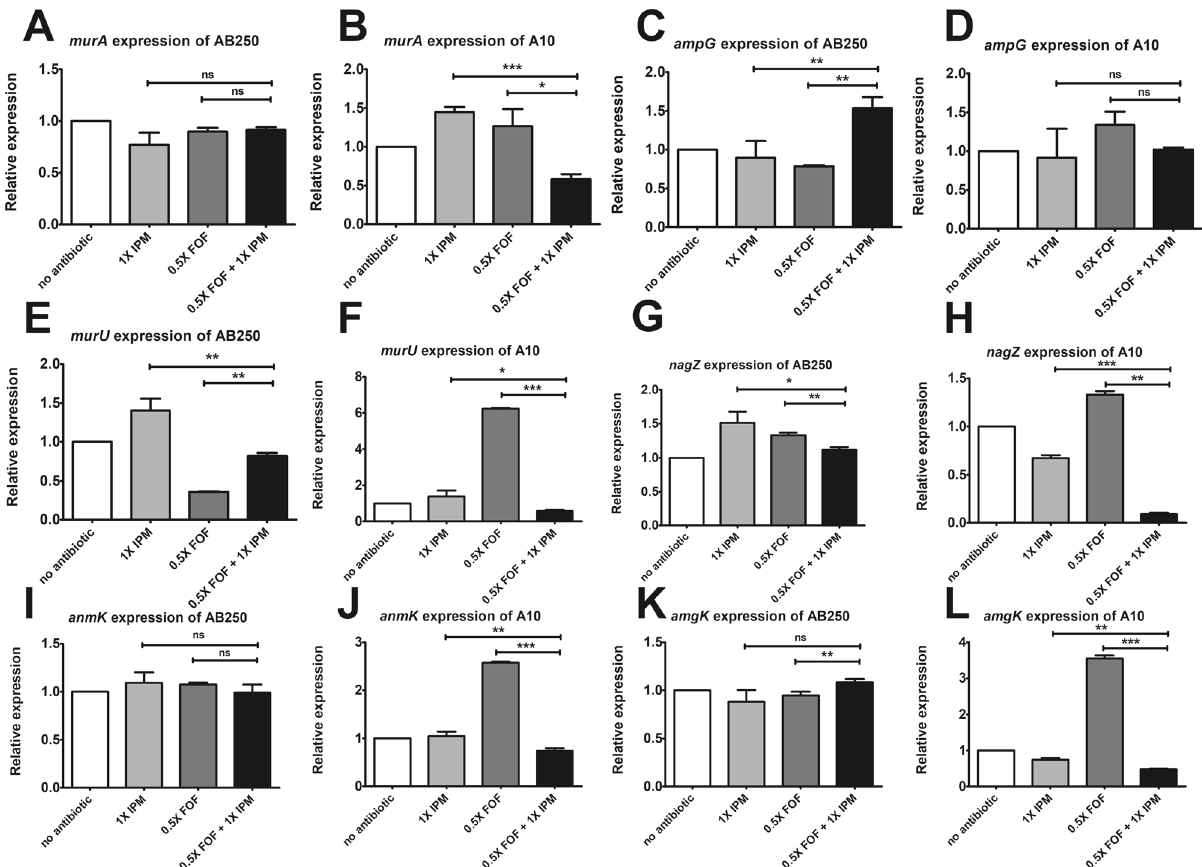
Figure 6. Relative mRNA expression of murA ( A , B ), ampG ( C , D ), murU ( E , F ), nagZ ( G , H ), anmK ( I , J ), and amgK ( K , L ) in the absence of antibiotic, the presence of 0.5× fosfomycin MIC, and the combination of 0.5× fosfomycin MIC with 1× imipenem MIC for 12 h determined by RT-PCR assay. The relative mRNA expressions at each condition were normalized to 16S rRNA expression and compared to the mRNA expression level of each isolate in the absence of antibiotic. All experiments were performed in triplicate. Mean values of the relative mRNA expression were plotted with error bars representing the standard error of the mean (n = 3). The p -values were calculated using one-way ANOVA, Dunnett’s multiple comparison test (* p -value ˂ 0.05; ** p -value < 0.01; *** p -value < 0.001 and ns,